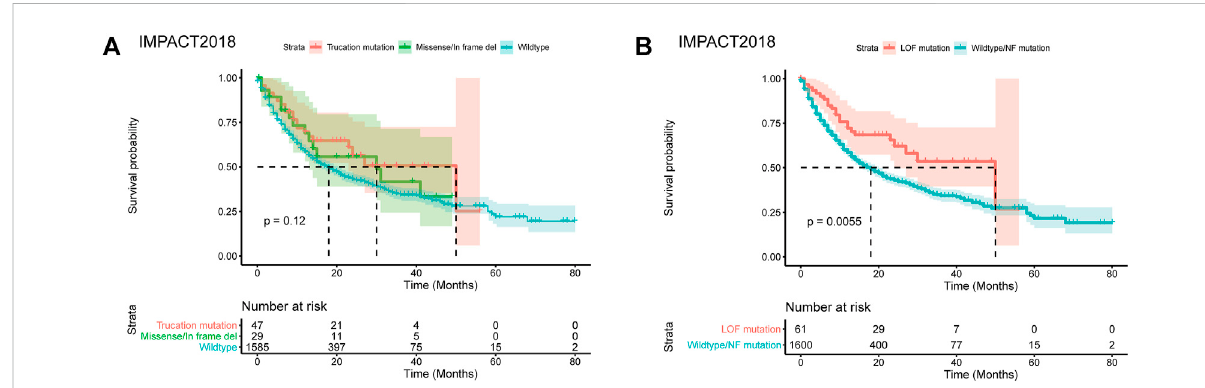
Predicting consequence of PBRM1 mutation by MutFormer. (A) The Kaplan-Meier curves of overall survival strati fi ed by truncation mutation, missense/inframedel,wildtypeofPBRM1intheIMPACT2018datasets. (B) TheKaplan-Meiercurvesofoverallsurvivalstrati fi edbylossoffunctionor wildtype/normal function mutation of PBRM1 in the IMPACT2018 datasets. LOF is short for loss of function. NF is short for normal